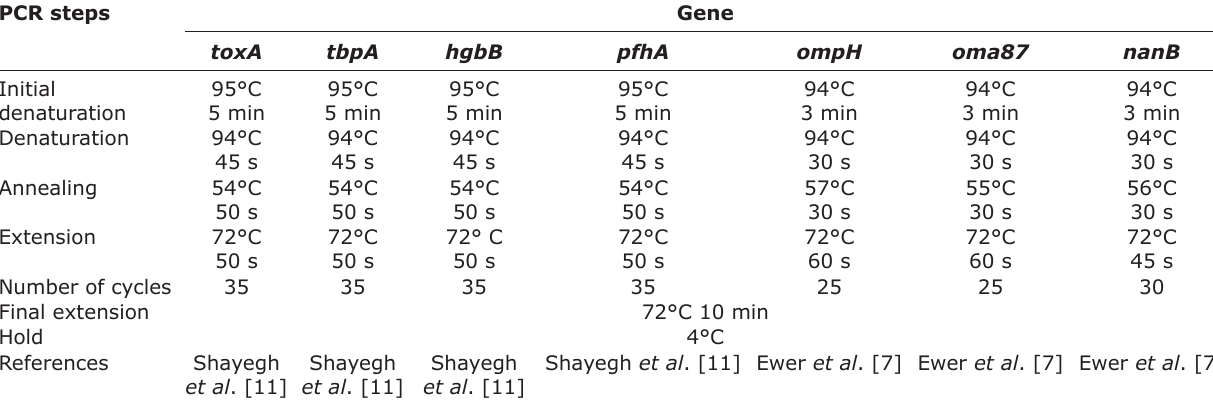
Table-2: Thermal cycling condition for the detection of virulence-associated genes of P. multocida . PCR steps